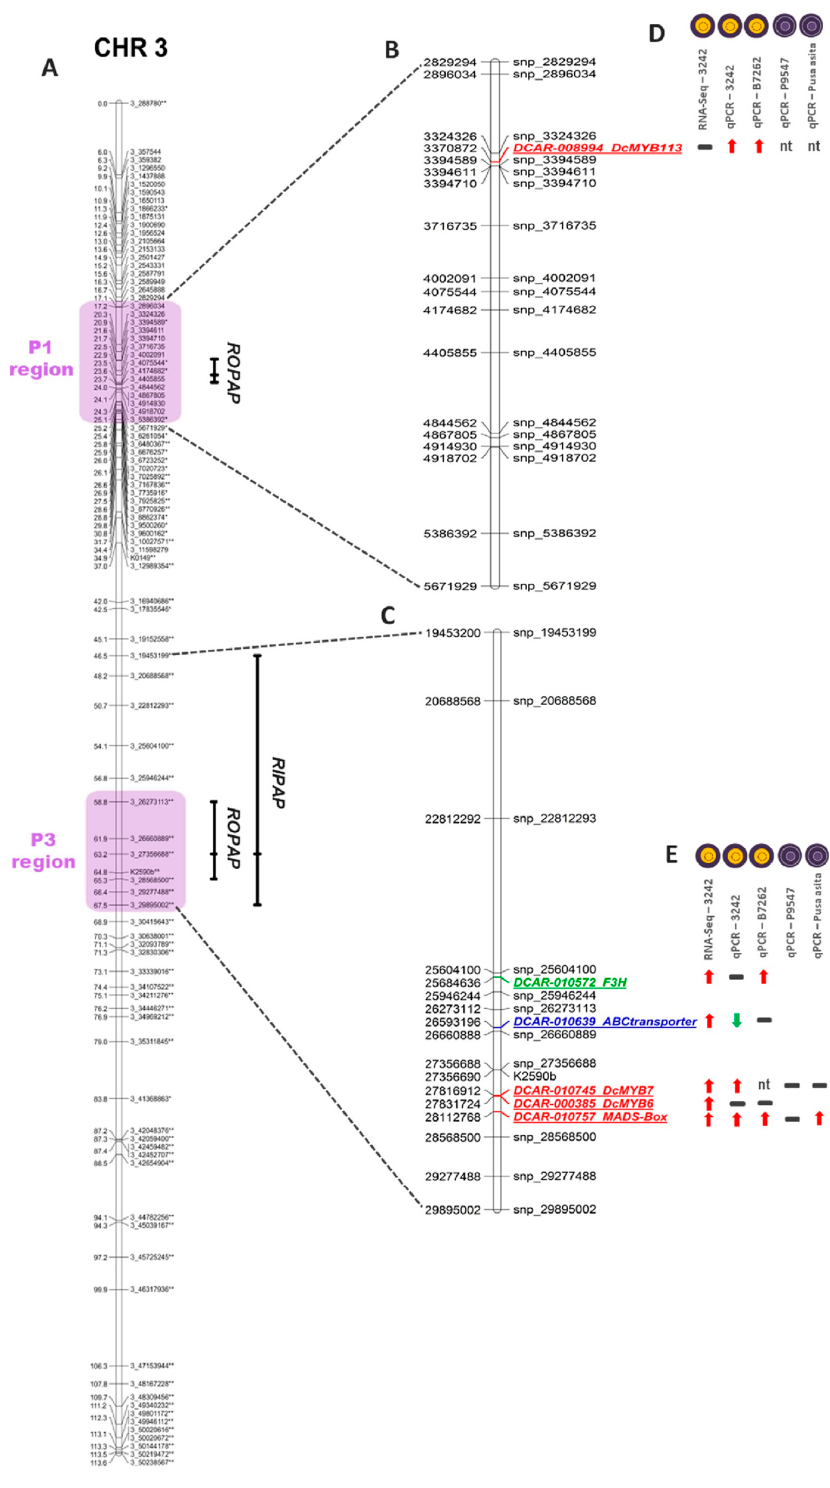
Figure 1. Genetic mapping of the phenotypic traits ‘root outer phloem anthocyanin pigmentation’ ( ROPAP ) and ‘root inner phloem anthocyanin pigmentation’ ( RIPAP ) in the 3242-F 2 population ( A ). Bars indicate the 1.5 LOD support interval and the position of the maximum LOD value for each binary trait. The P 1 and P 3 regions in chromosome 3, as delimited by Bannoud et al.